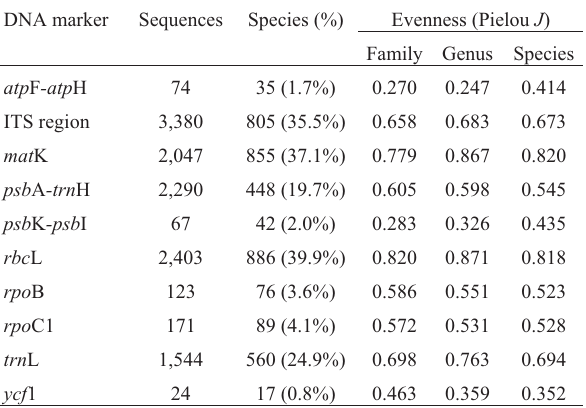
Table 2 - Number of sequences, species and the evenness index of the ten DNA markers considered in this study regarding the São Paulo tree flora. In parentheses, the proportion of species sequenced with respect to the to- tal of tree species occurring in São Paulo. DNA marker